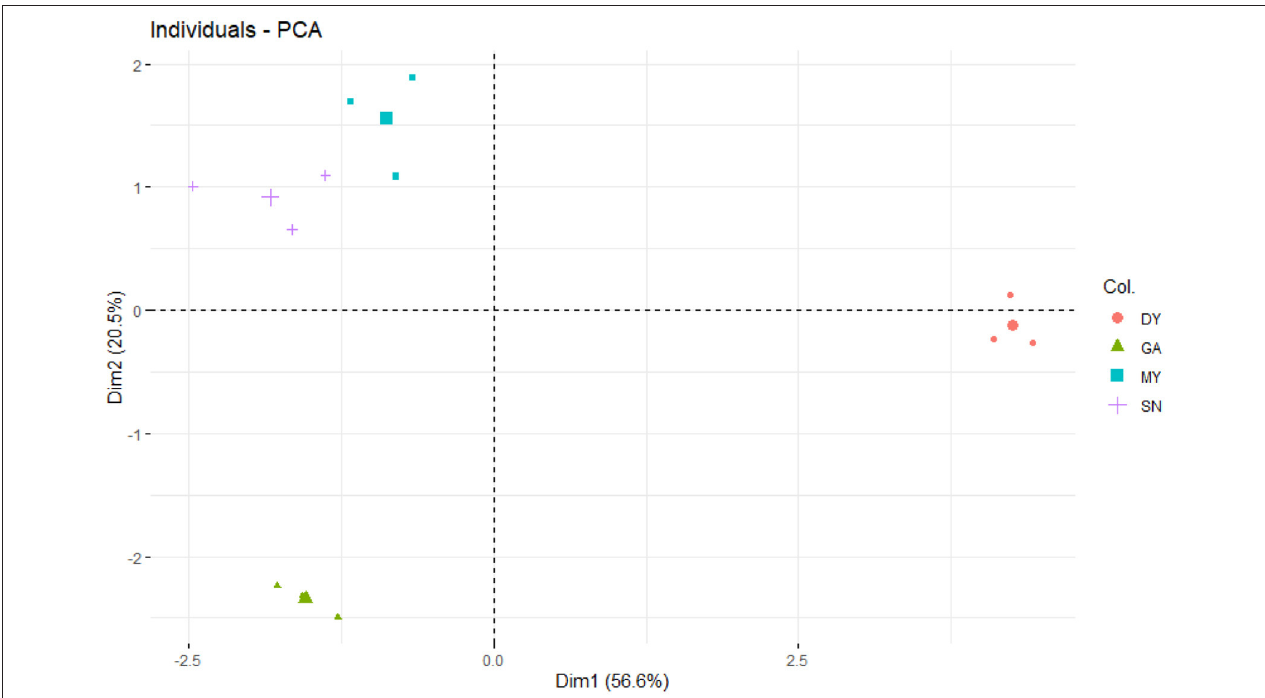
FIGURE 1 | Principal component analysis (PCA) of the soil physicochemical parameters in the four sampled sites. DY, Deyang City; GA, Guang’an City; MY, Mianyang City; SN, Suining City.